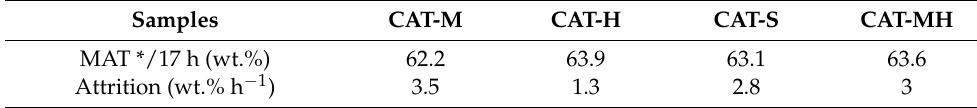
Table 5. Physicochemical properties of catalysts. Samples CAT-M CAT-H